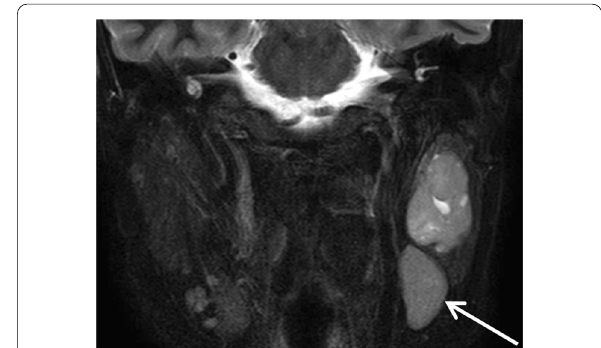
Fig. 16 Acinic cell carcinoma. Satellite lymphadenomegaly on frontal fat sat T 2 ‑weighted